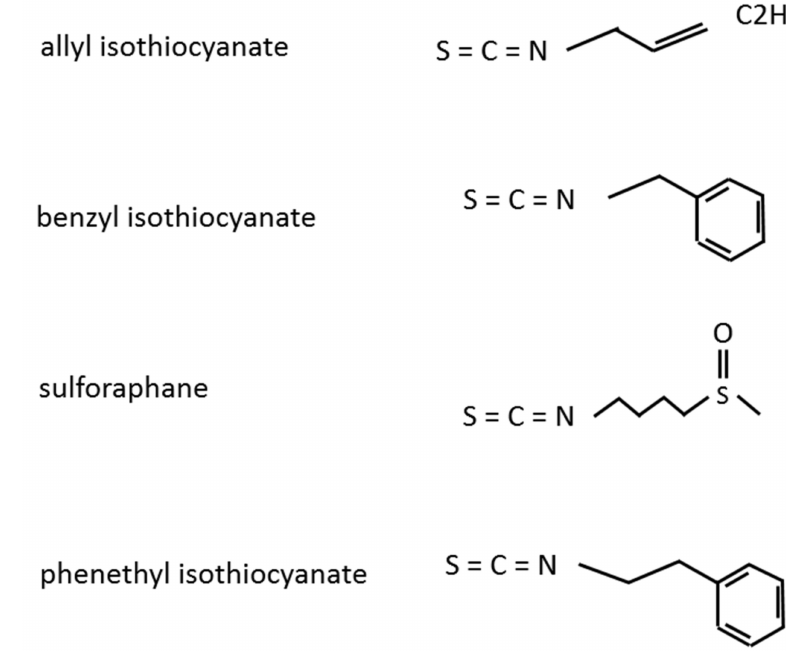
Figure 1. Structures of the isothiocyanate